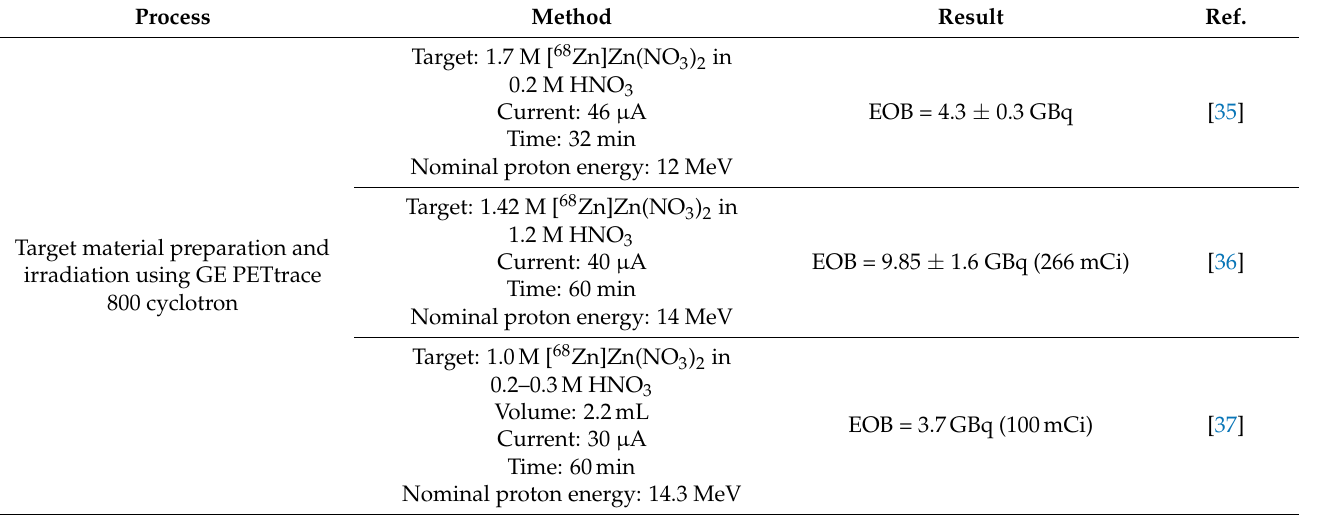
Table 6. Published articles related to the production of cyclotron 68 Ga.